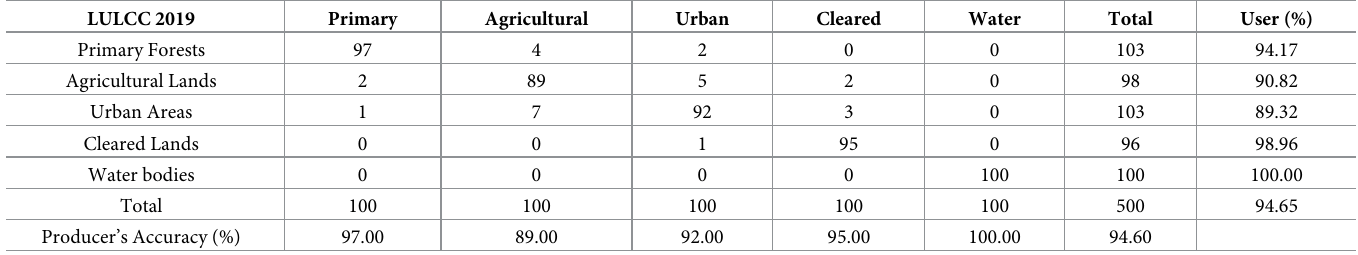
Table 2. Confusion matrix of 2019 land cover